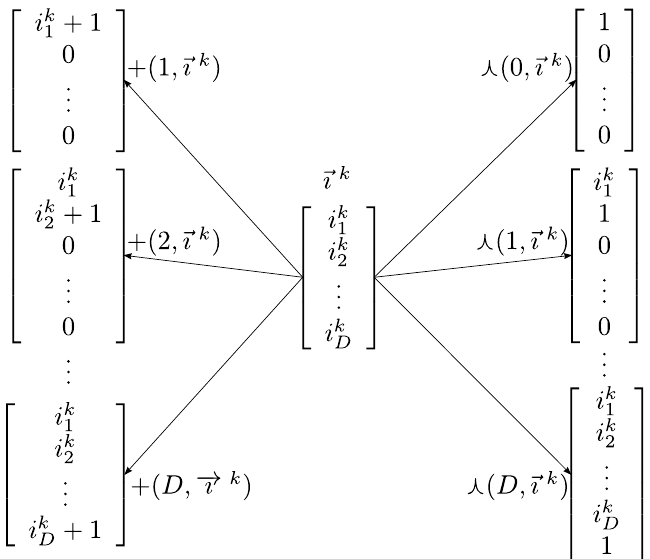
#» ı k can be increased